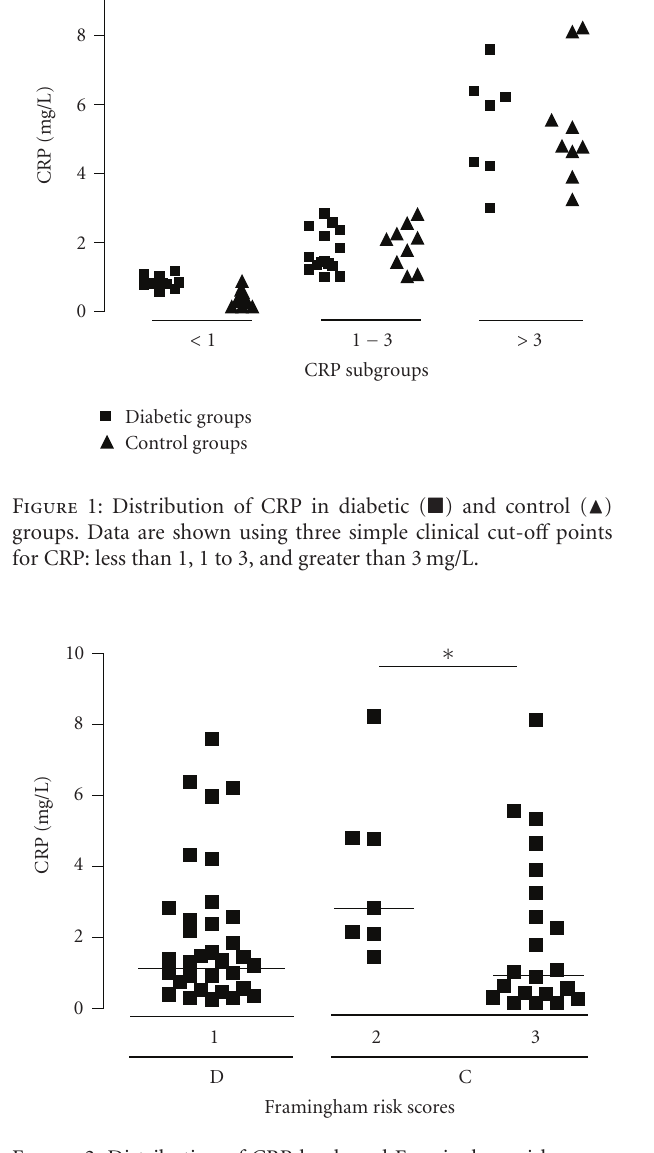
Figure 2: Distribution of CRP levels and Framingham risk scores (1, 2, and 3) in diabetic (D) and control (C) groups. The solid lines represent the median values of each subgroup; ∗ = P < . 05.